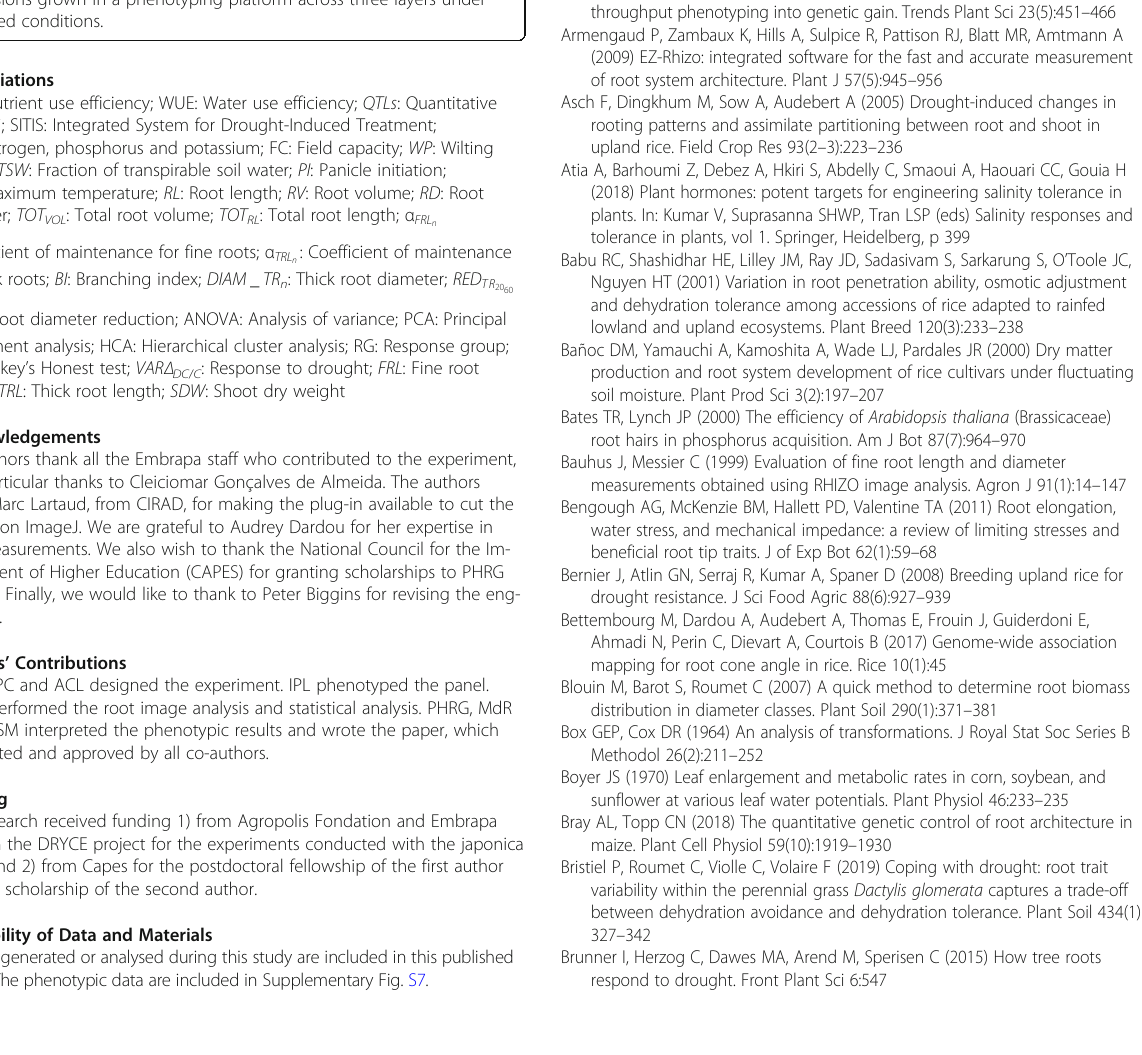
Additional file 8: Supplementary Table S1. Pearson ’ s correlation matrix for 29 traits (28 root traits, and one shoot trait) among 17 rice accessions grown in a phenotyping platform across three layers under irrigated